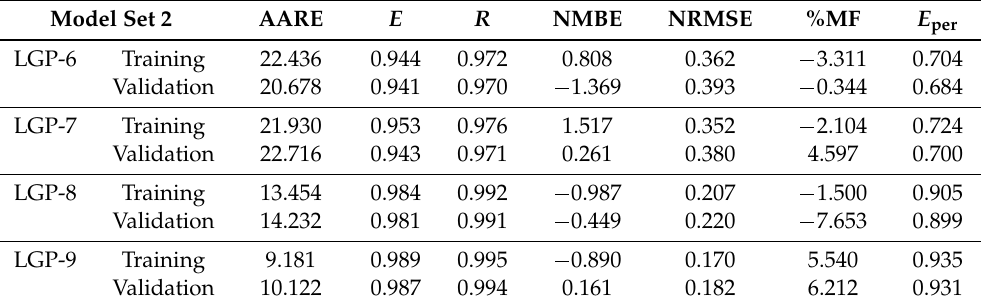
Table 7. Statistical parameters for LGP-6 through LGP-9.